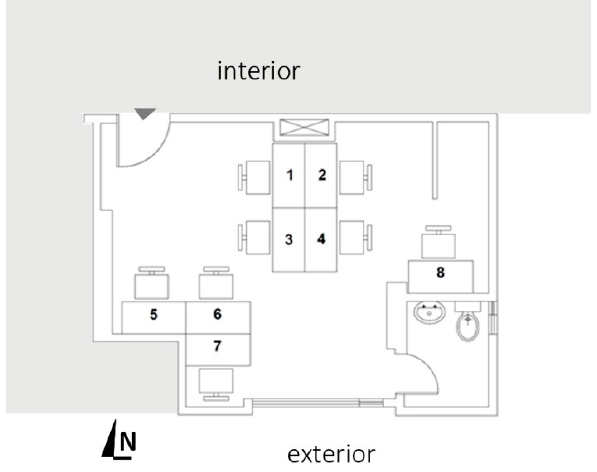
Figure 2. Plan of office and measurement points (1–8).